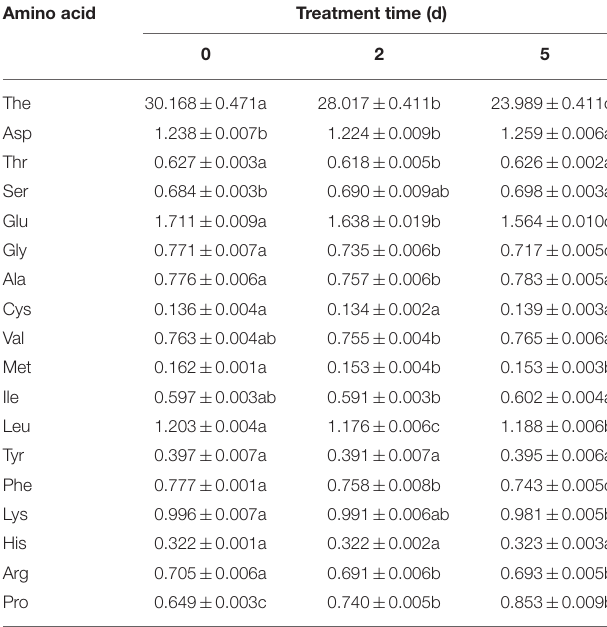
Values are presented as the mean ± SD from three independent experiments, and different letters indicate significant differences at P < 0.05 according to Duncan’s